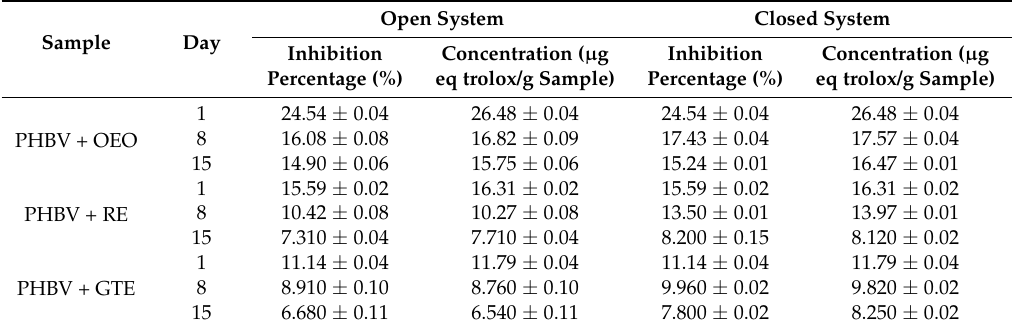
Table 8. Inhibition percentage (%) of 2,2-diphenyl-1-picrylhydrazyl radical (DPPH) and concentration (eq. trolox/g sample) of DPPH for the electrospun poly(3-hydroxybutyrate- co -3-hydroxyvalerate) (PHBV) films containing oregano essential oil (OEO), rosemary extract (RE), and green tea tree extract